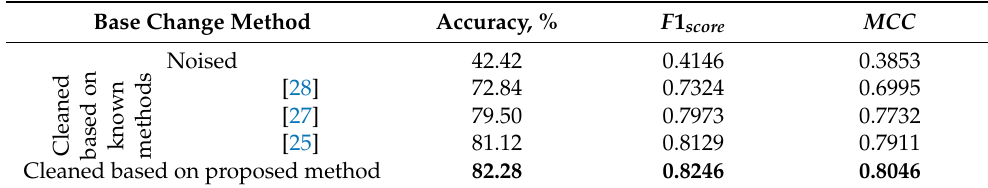
Table 5. Criteria and metrics of recognition accuracy of the CIFAR10 base, previously cleared of 10% random-valued impulse